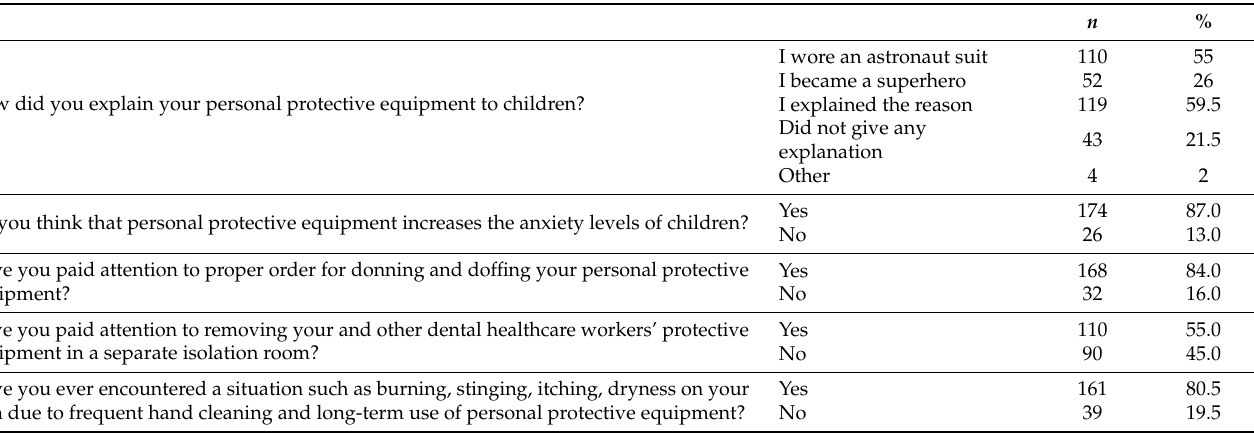
Table 9. Participants’ attitudes related to PPE.